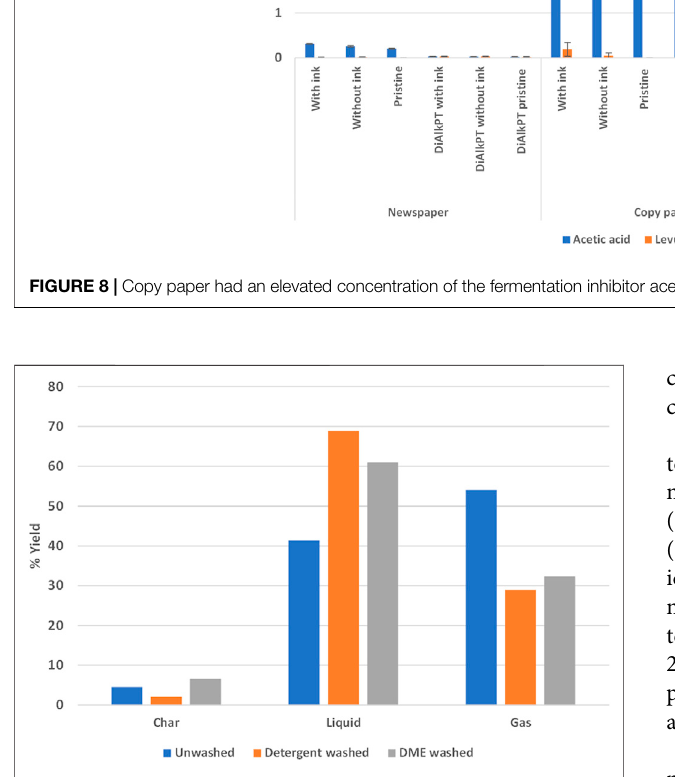
FIGURE 9 | Detergent and DME washed plastic produced an increased yield of liquid oil during pyrolysis.